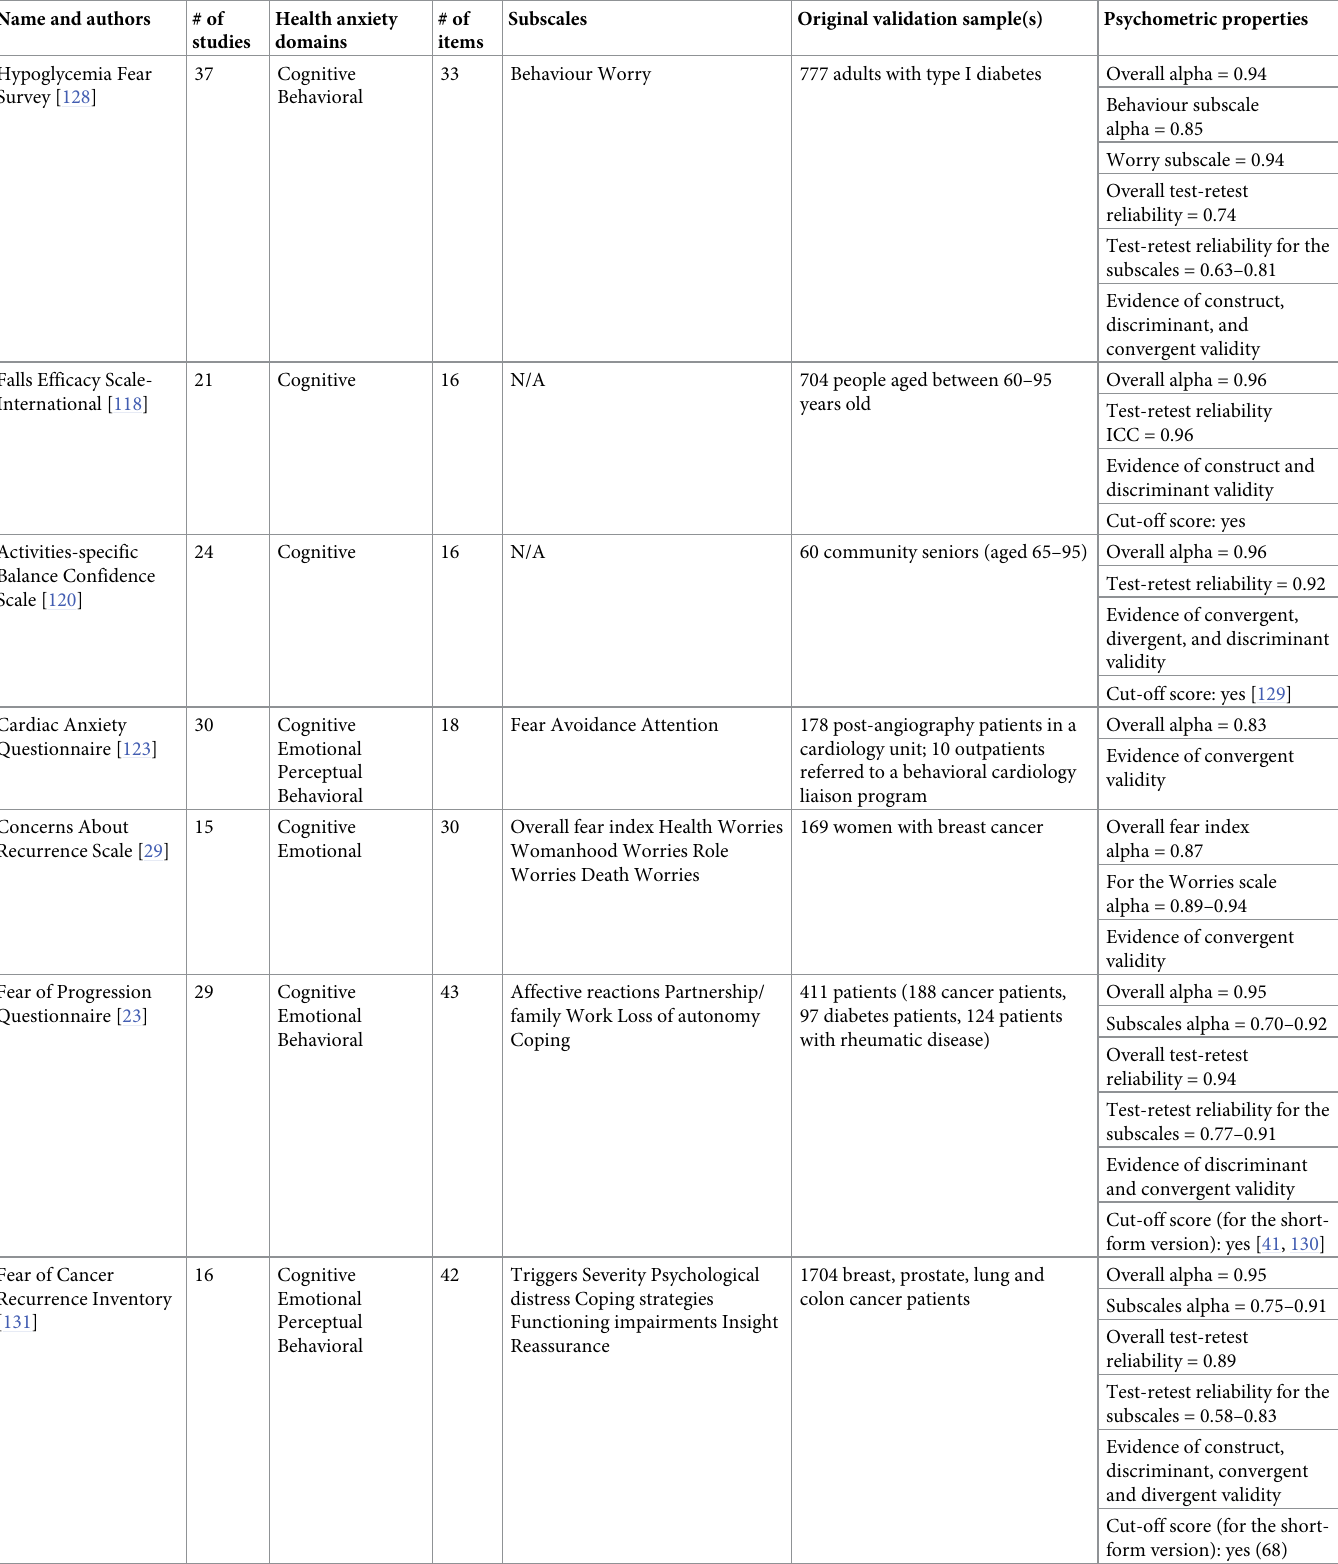
Table 4. Description of the health anxiety measures that were cited by more than 10 articles. Name and